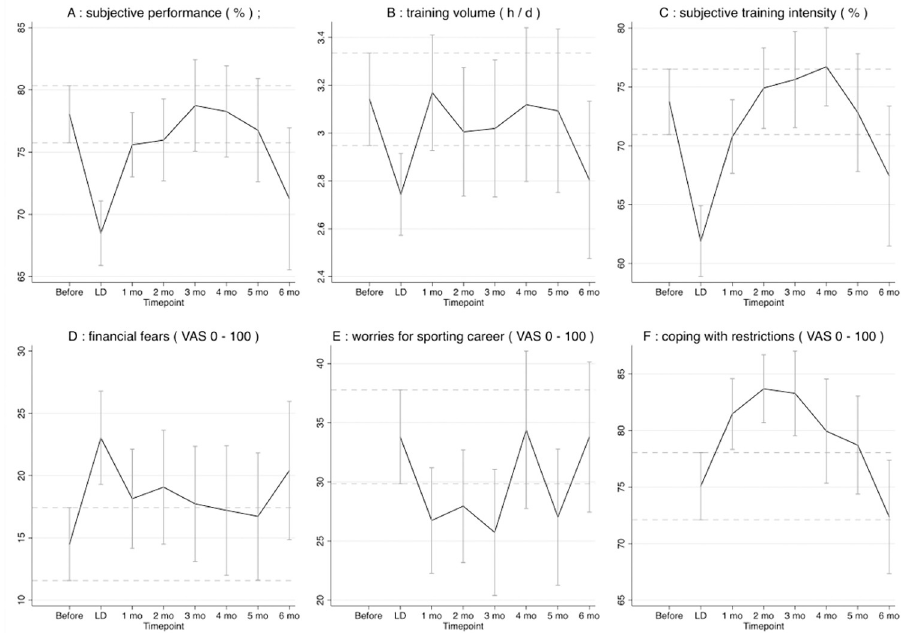
Fig 2. Sports performance, training load, worries, fears, and coping. (A) subjective performance (%); (B) training volume (h/d); (C) subjective training intensity (%); (D) financial fears (VAS 0–100); (E) worries for sporting career (VAS 0–100); (F) coping with restrictions (VAS 0–100). The dotted lines represent the 95% CI interval of the “before”